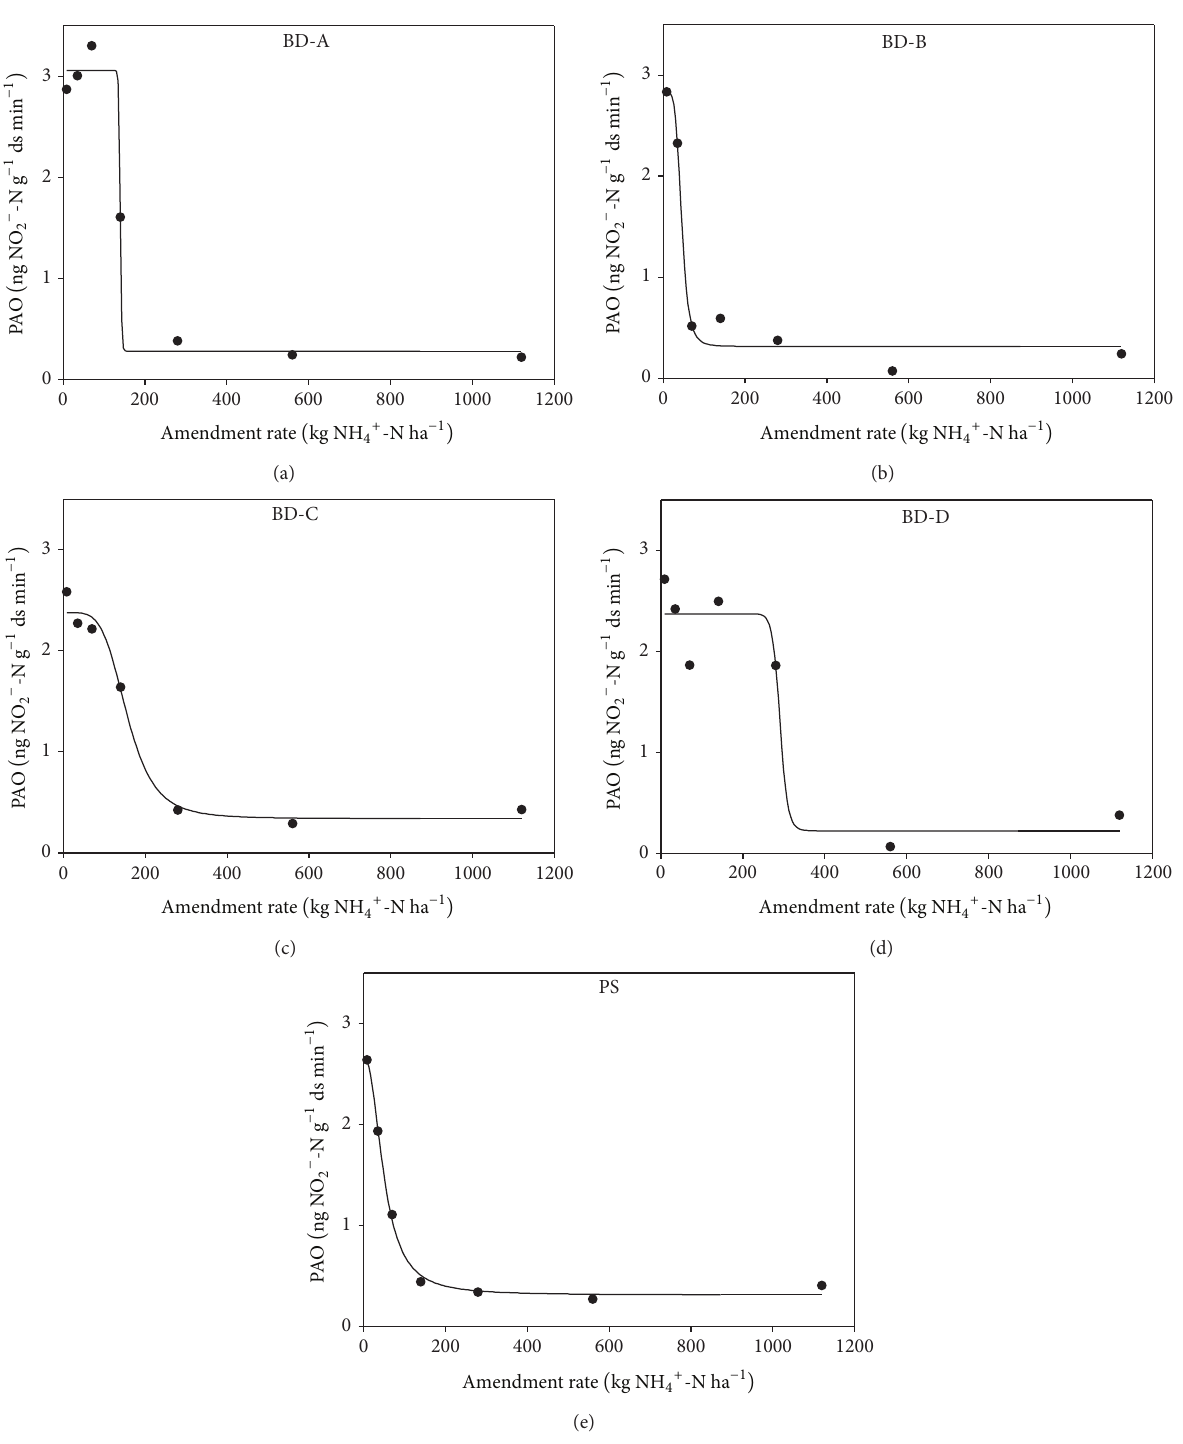
Figure 3: Potential ammonium oxidation (PAO) in the soil at seven amendment rates of four types of biogas residues (BD-A, BD-B, BD-C, and BD-D) and pig slurry